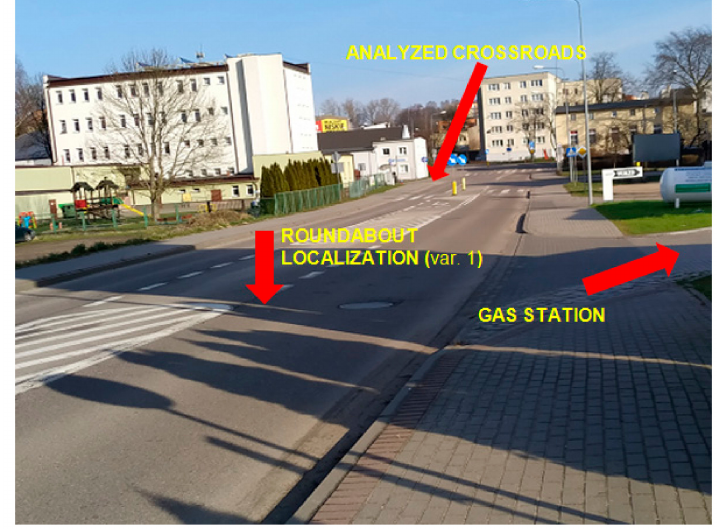
Figure 4. Destination location of the roundabout in option